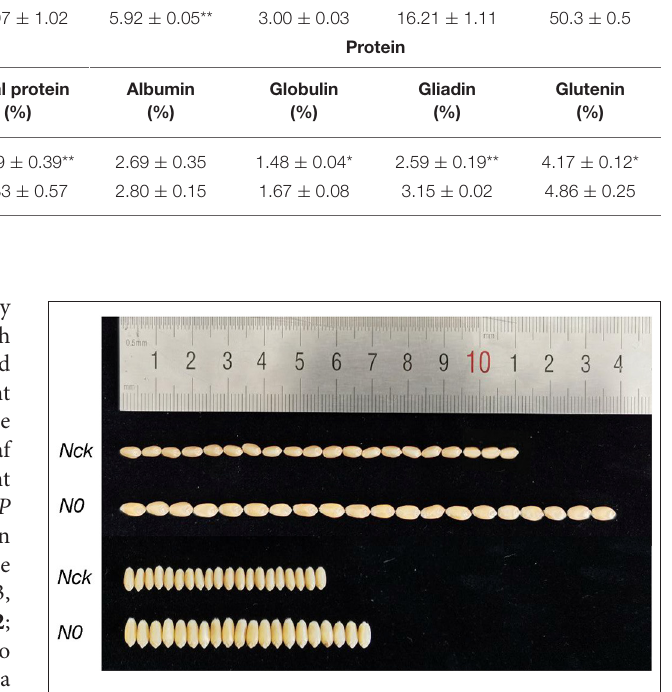
FIGURE 1 | Comparison of mature grain length and width with N0 and Nck